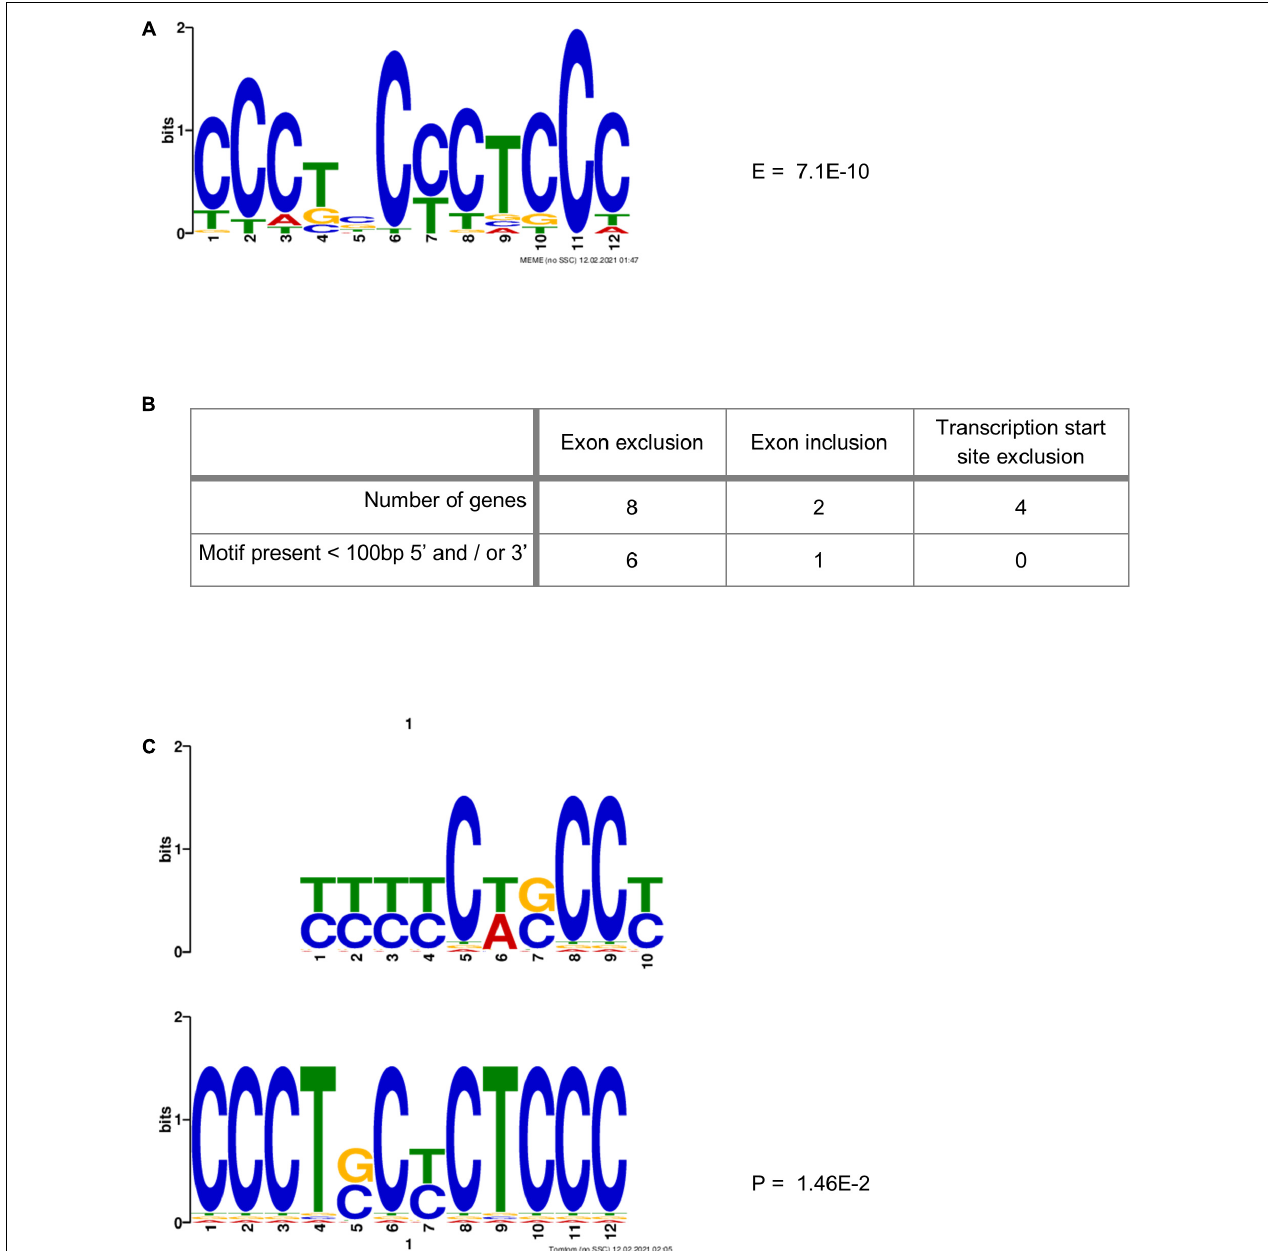
FIGURE 5 | PCBP2-specific C-rich motif adjacent to exons skipped upon PCBP2 knockdown. (A) MEME motif enrichment analysis revealed a highly significant motif (E-value: 7.1E-10) in the intronic regions surrounding in- or excluded exons or transcription start sites upon PCBP2 silencing. (B) The motif was found in 75% of genes in regions within 100 bp from the exon boundaries of exons excluded upon PCBP2 silencing (see locations of motif in Supplementary Figure 2 ). The adjacent regions of excluded transcription start sites did not contain the motif, while the regions adjacent to the included exon of one of the two genes contained the motif. (C) The motif identified in the data set of this study (lower motif) was compared to the motif identified by Ji et al. (2016) (upper motif) by the Tomtom motif comparison tool which showed that the motifs significantly matched ( p -value: 1.46E-2), but that they are not the